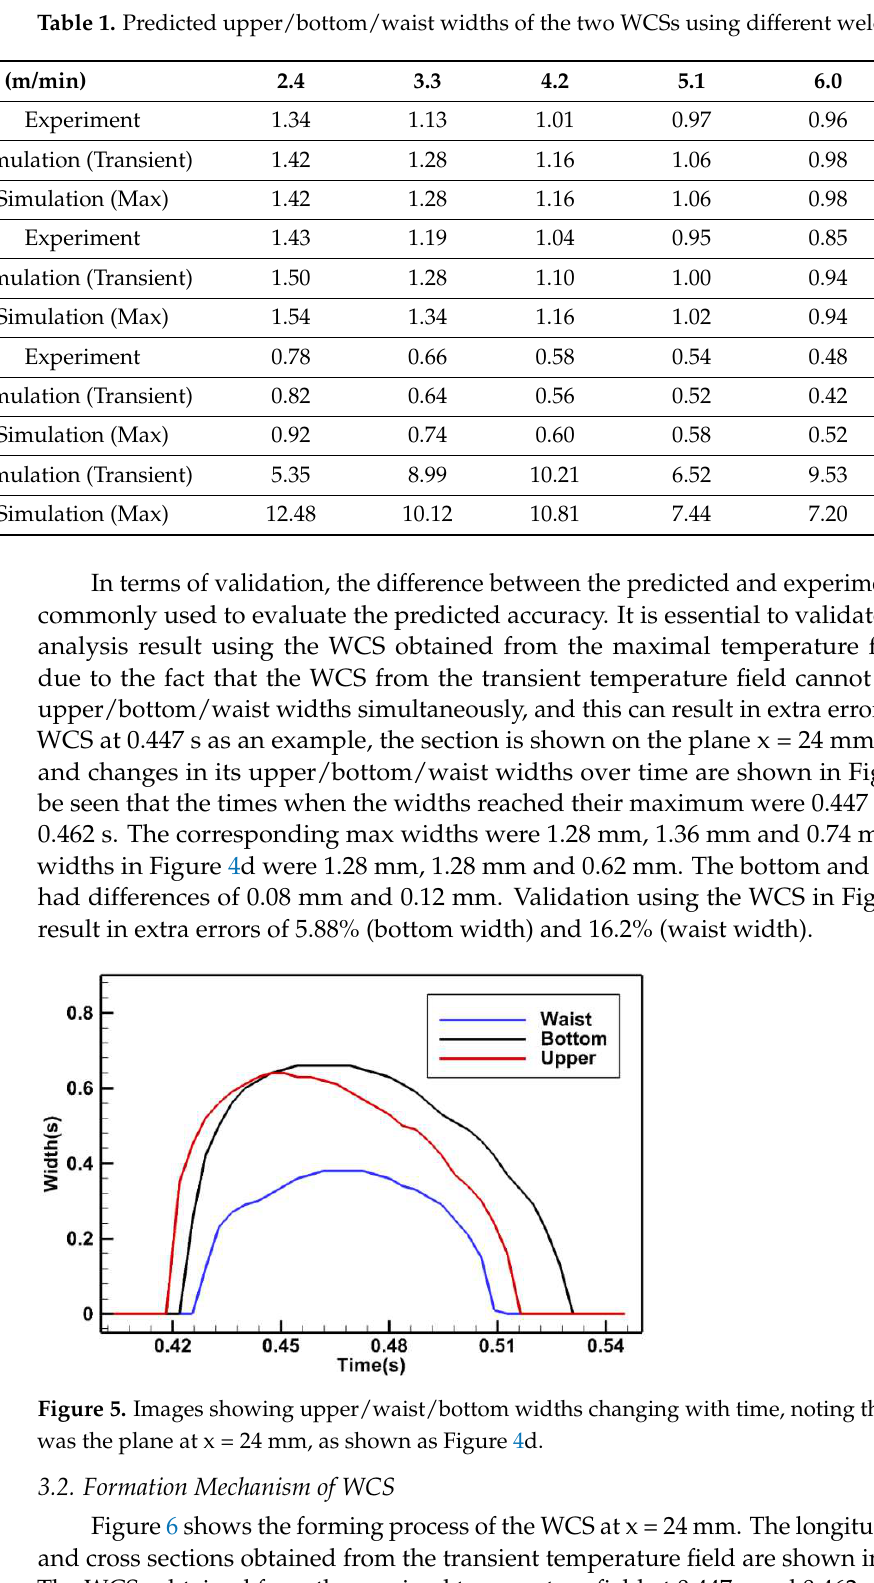
and cross sections obtained from the transient temperature field are shown in Figure 6a–h. The WCSs obtained from the maximal temperature field at 0.447 s and 0.462 s are shown in Figure 6i,j, respectively, namely the max temperature of each node over time until 0.447 s and 0.462 s. The forming process can be divided into two phases. Phase I was from 0.429 s to 0.447 s, when heat transfer was dominated by convection. Phase II was from 0.447 s to 0.462 s, when heat transfer was dominated by